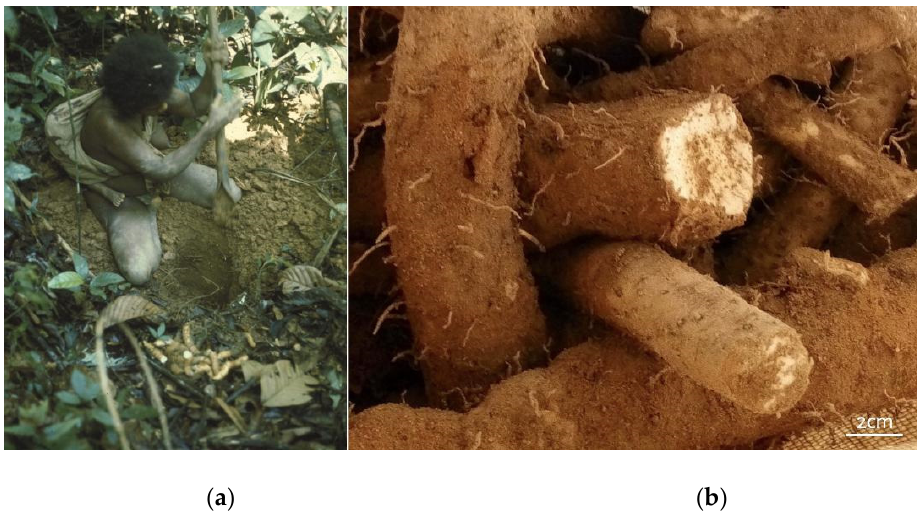
Figure 3. ( a ) Batek woman digging the tubers known as takop ( Dioscorea orbiculata ); ( b ) harvested tuber fragments. Source : ( a ) Endicott, K. M. (1976). Woman digging tubers. Keene State College Orang Asli Archive, Kirk & Karen Endicott Collection, accessed on 4 November 2021, reproduced with permission; ( b ) Wong Pui May (2018), reproduced with